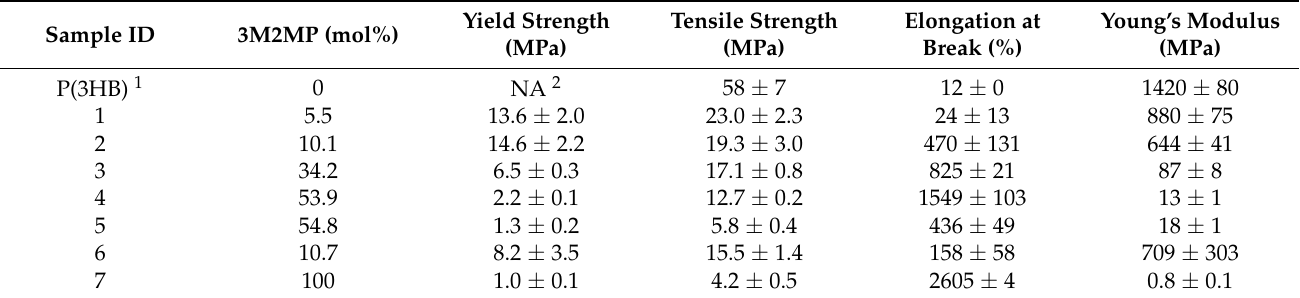
Figure 9. Elongation of P(3M2MP) (Sample 7) by manual deformation. ( a ) Before deformation; ( b ) during deformation; ( c ) after deformation. Table 4. Mechanical properties of the samples ( n = 3).